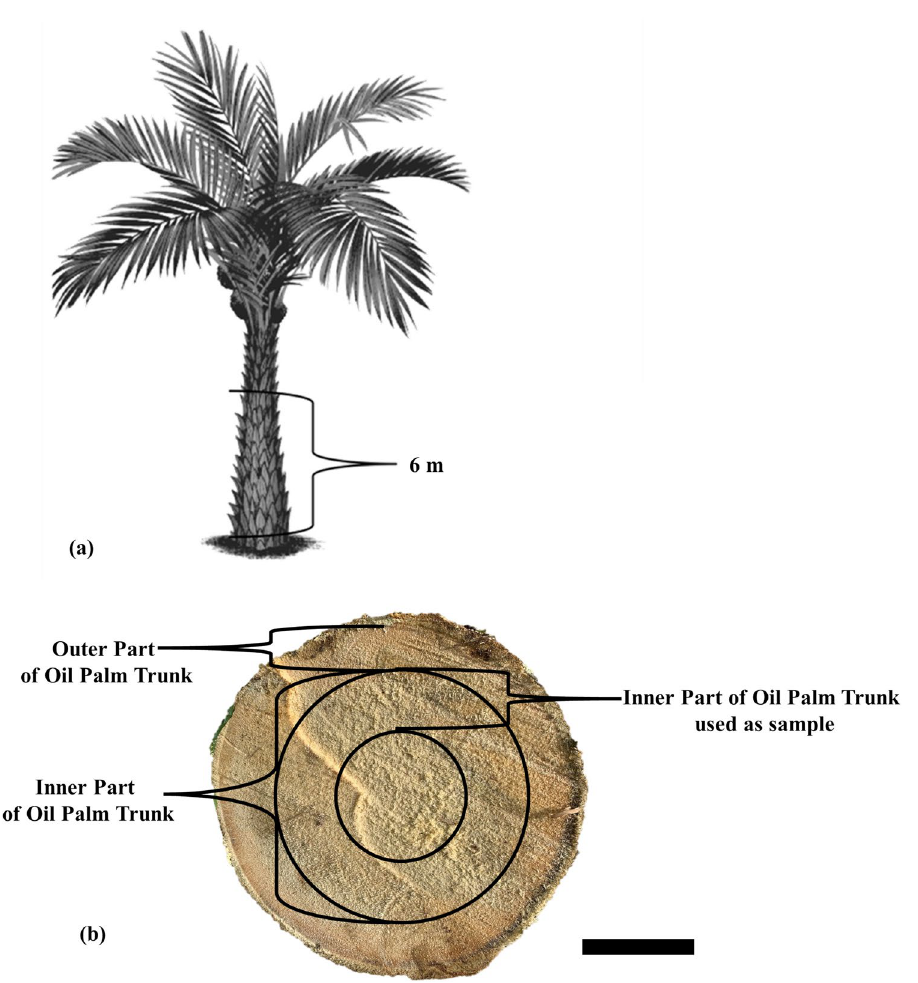
Figure 1. Illustration of sampling of inner part of oil palm trunk (IOPT). ( a ) Partition of axial direction. ( b ) Black circled area in cross section indicates the IOPT used as a sample in this study. Scale bar: 100